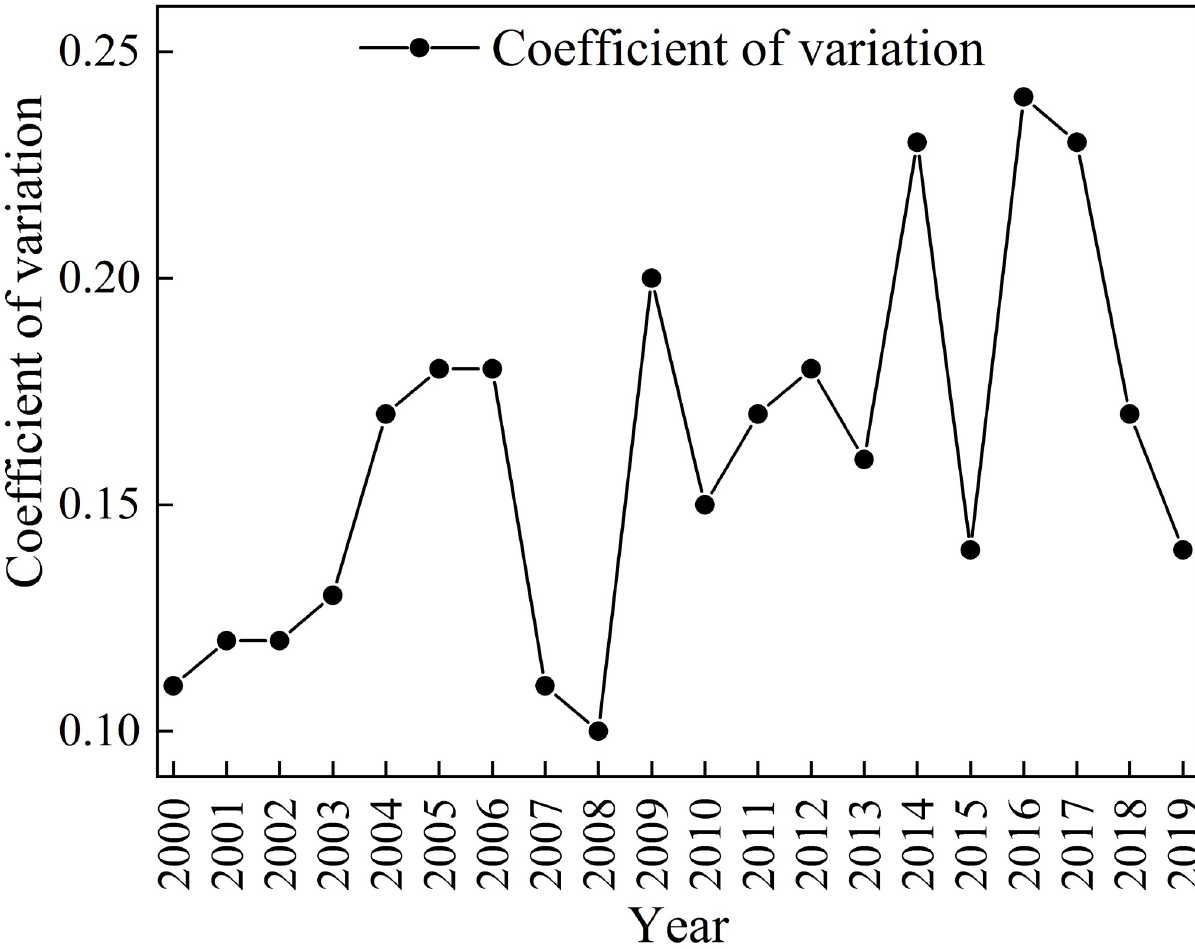
Fig 7. Observed changes in the coefficient of variation of river length from 2000 to